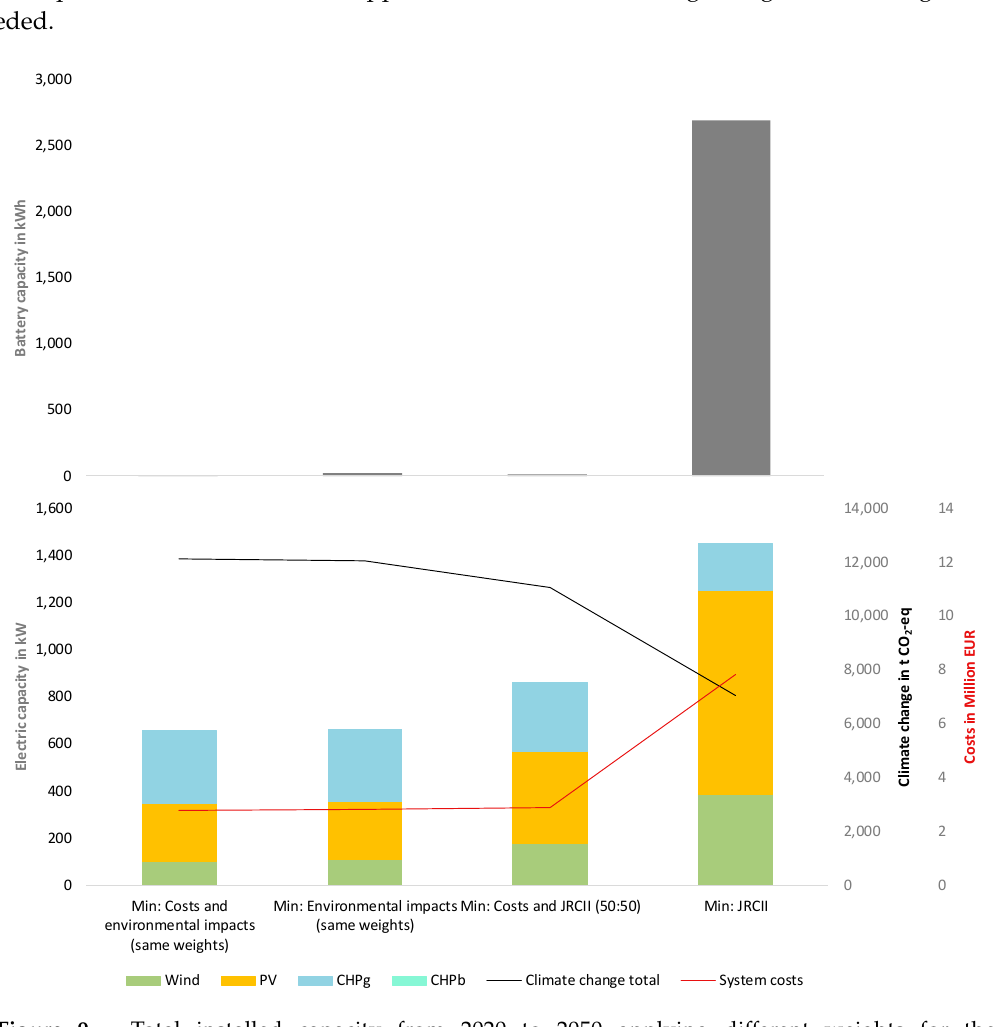
Figure 9. Total installed capacity from 2020 to 2050 applying different weights for the multi-criteria optimisation.